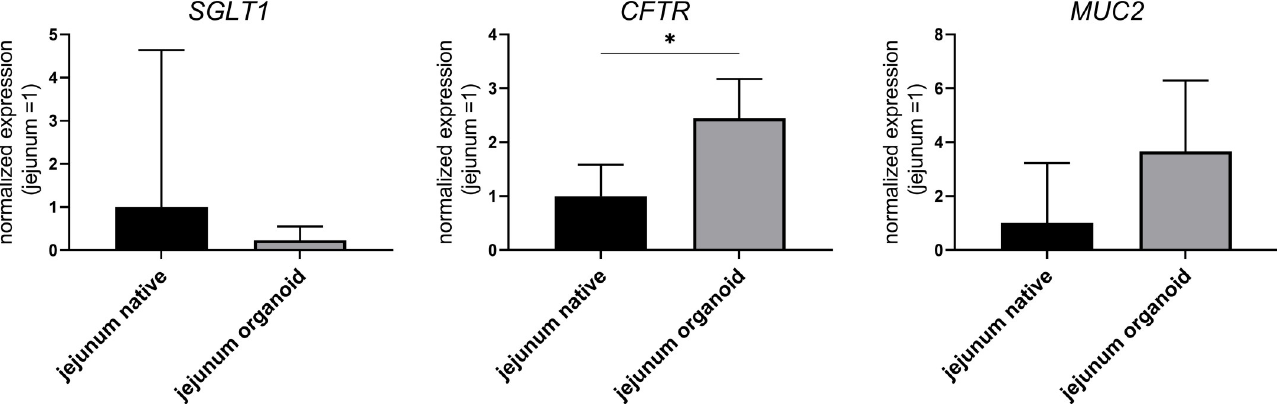
Fig 2. Gene expression of sodium/glucose cotransporter 1 ( SGLT1 ), cystic fibrosis transmembrane conductance regulator ( CFTR ) and mucin 2 ( MUC2 ) in intestinal organoids of the porcine jejunum cultivated for seven days in comparison to native tissue. Reference genes ribosomal protein S23 and ribosomal protein P0 were used for normalization of expression. Values shown are the geometric mean ± geometric standard deviation (SD) of four independent experiments. � p < 0.05.